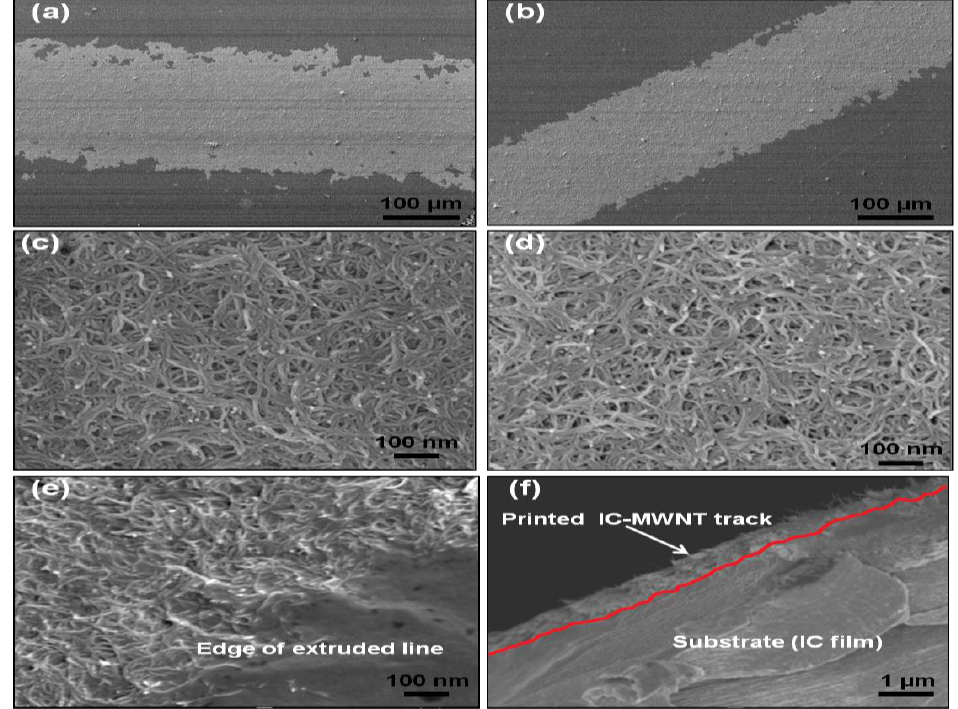
Figure 10. SEM images of G-MWNT extruded patterns onto ( a , c ) glass; ( b , d ) PET sheet and ( e ) IC film substrates; ( f ) Cross-sectional view of G-MWNT tracks printed onto IC film substrate. The red line indicates interface between track and the substrate.